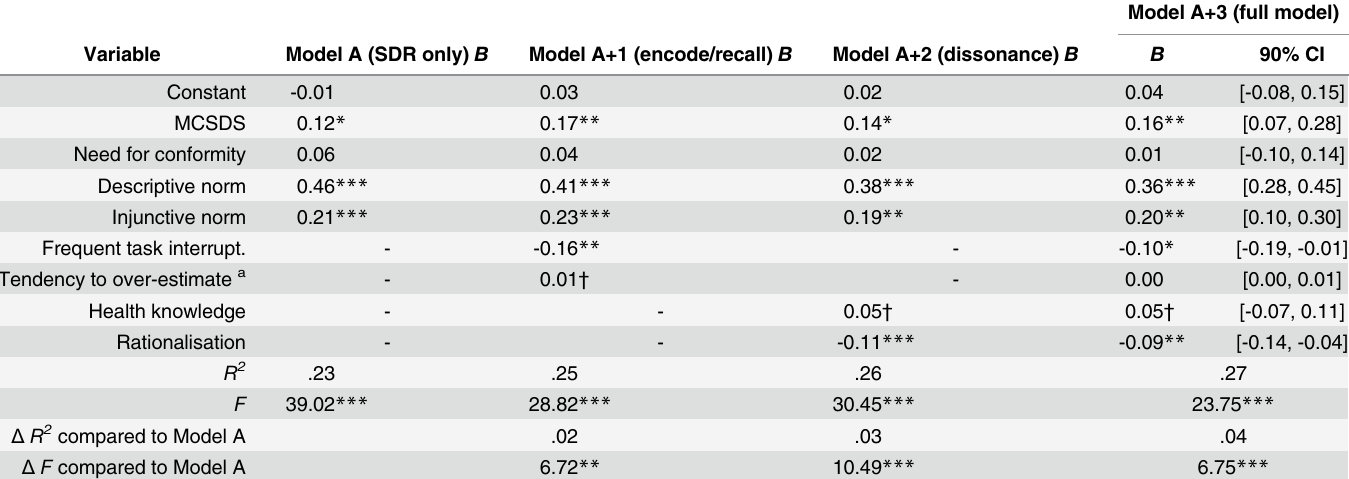
Table 4. Factors explaining over-reporting in food-related handwashing: Multiple regression